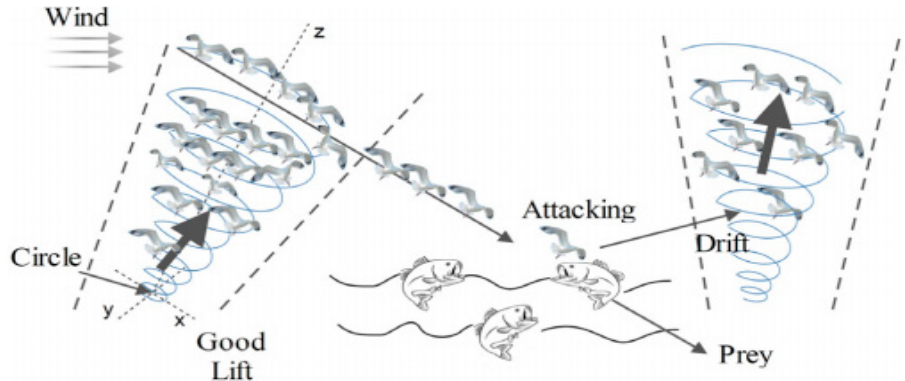
Figure 1. The seagull migration and attack process .